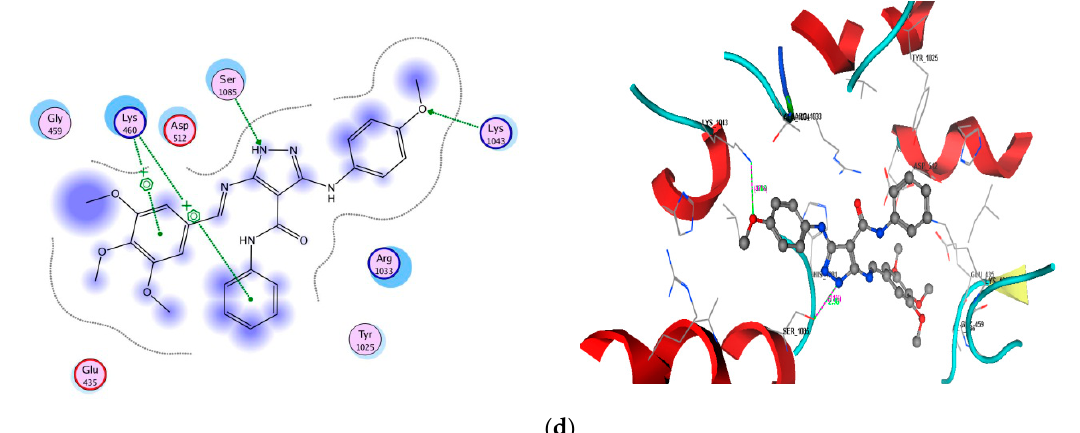
Figure 4. ( a ) 2D and 3D interactions of compound 8a in the active site of 1DLS. ( b ) 2D and 3D interactions of compound 9b in the active site of 1DLS. ( c ) 2D and 3D interactions of compound 8a in the active site of 2XCT. ( d ) 2D and 3D interactions of compound 9b in the active site of 2XCT.